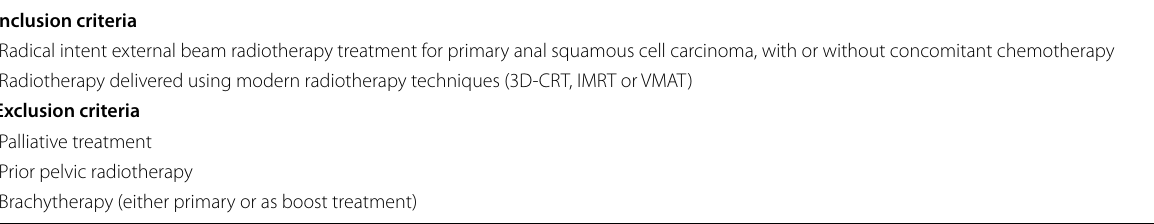
3D-CRT Three-dimensional conformal radiation therapy, IMRT Intensity-modulated radiation therapy, VMAT Volumetric modulated arc therapy